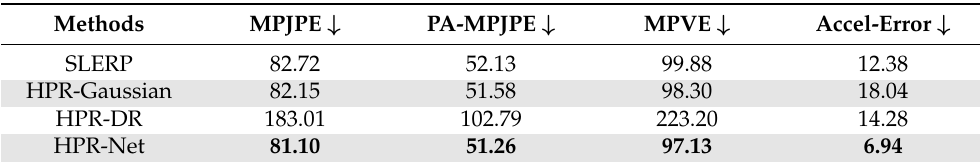
Table 7. Comparison of refinement performance between HPR-Net and other pose sequence refine- ment methods on the 3DPW dataset. Bold values indicate best